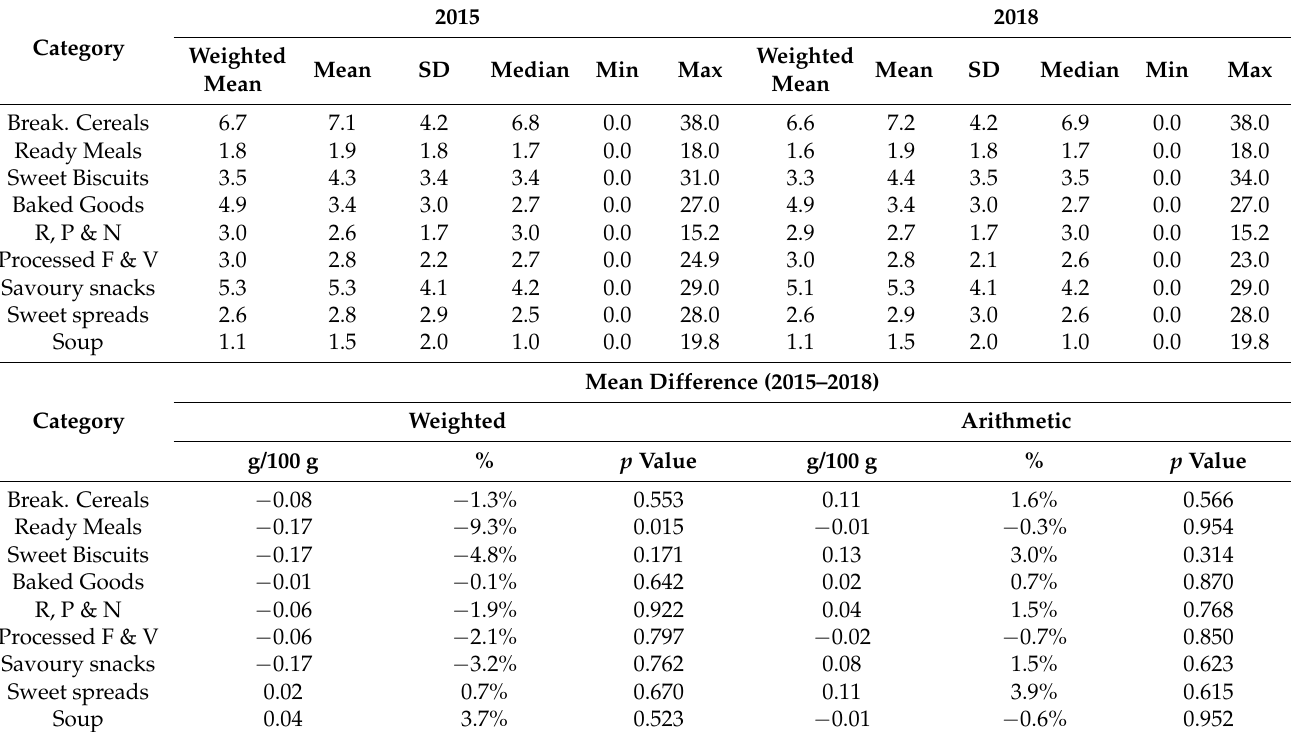
Table 5. Summary statistics and variations of fibre content (in g/100 g) for selected packaged food categories in